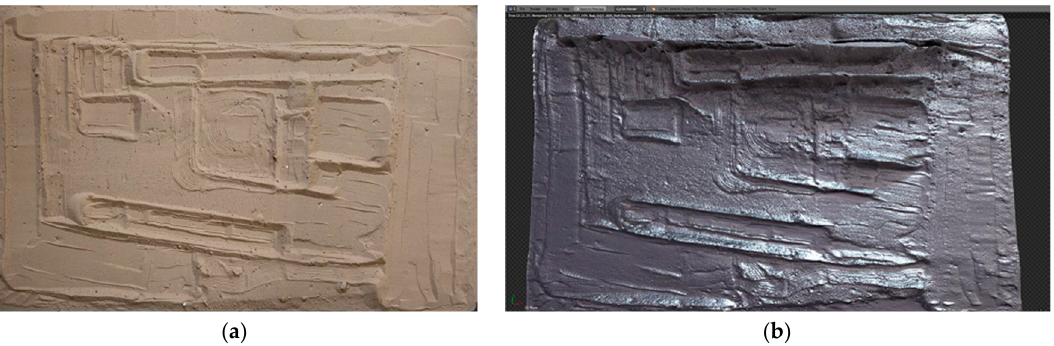
Figure 16. Ronen Sharabani, Mountain Outline, plate #1 ( a ) sand table in process, 90 cm × 125 cm; ( b ) digital mold.